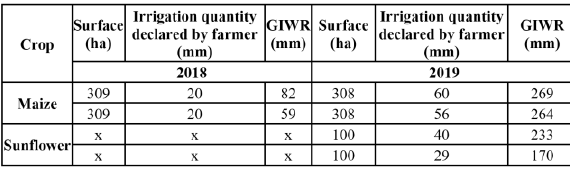
Table 2. Gross irrigation water requirement retrieved based